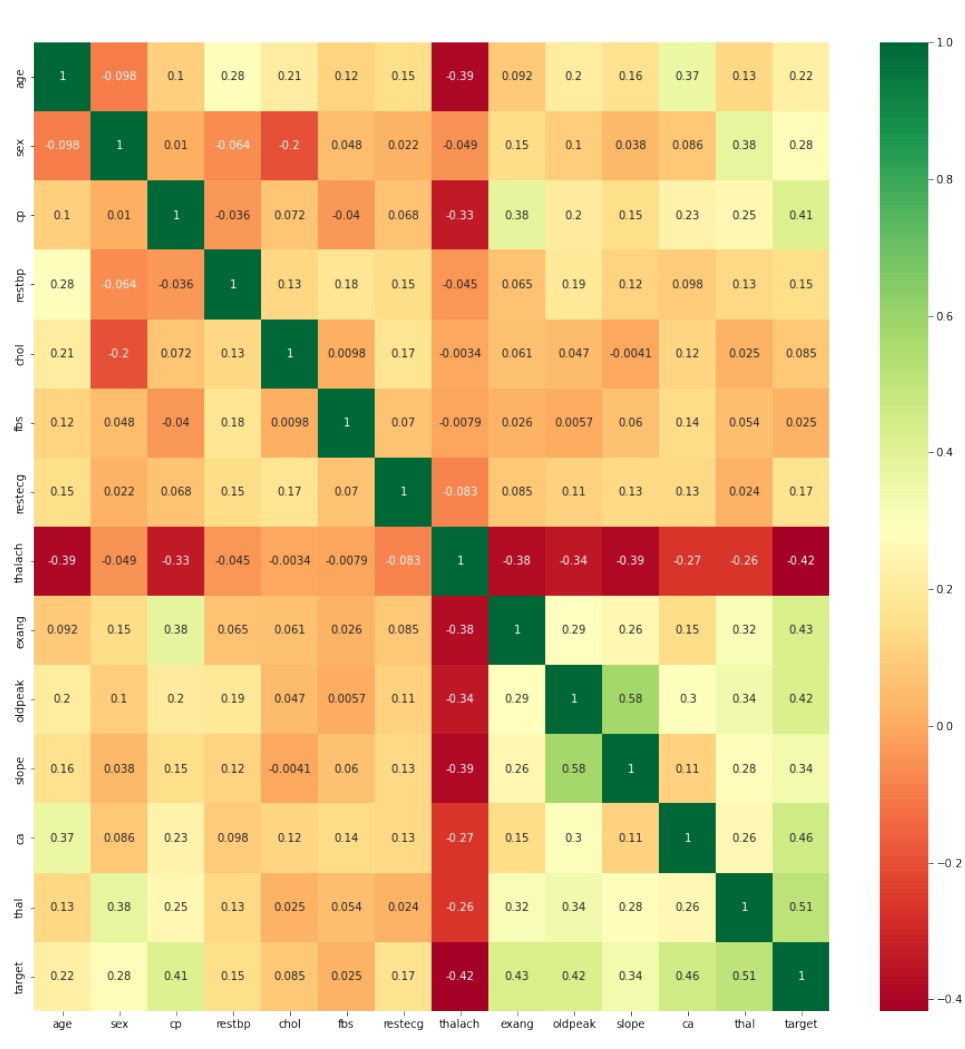
Figure 1. Correlation